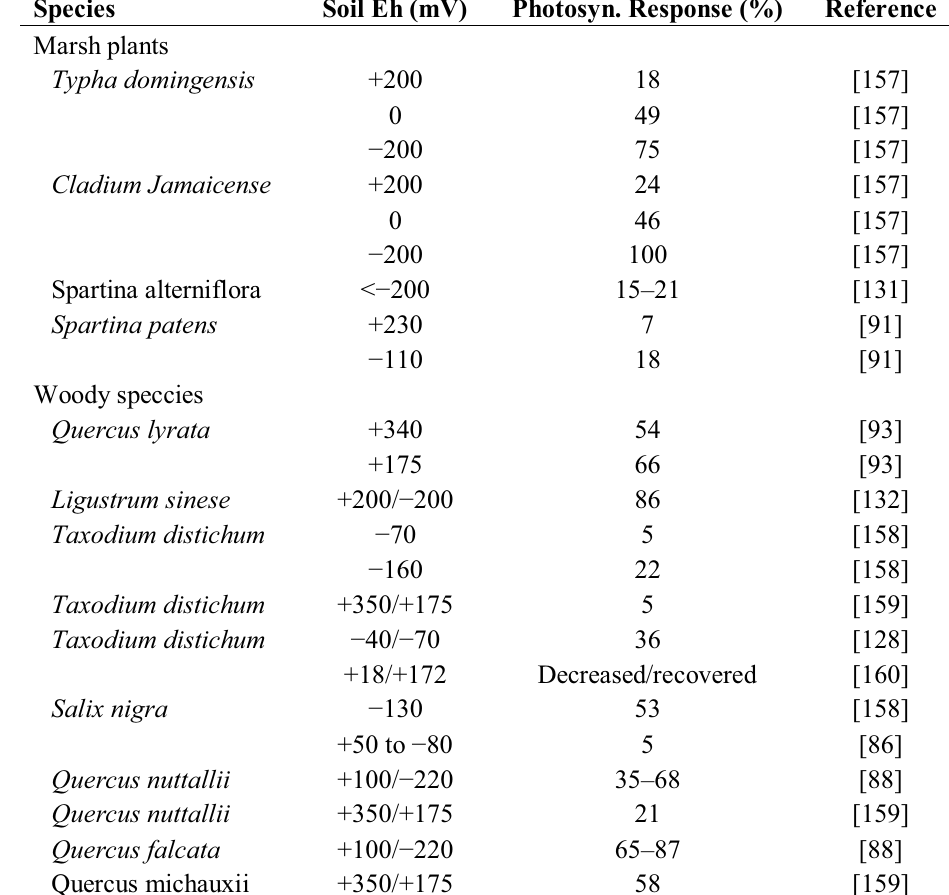
Table 1. Photosynthetic responses of selected marsh plants and wetland/bottomland woody species to the intensity of soil reduction. Values represent percent reduction in net photosynthetic rates compared to plants grown under oxidized (Eh > +400 mV) conditions or percent of pre-stress